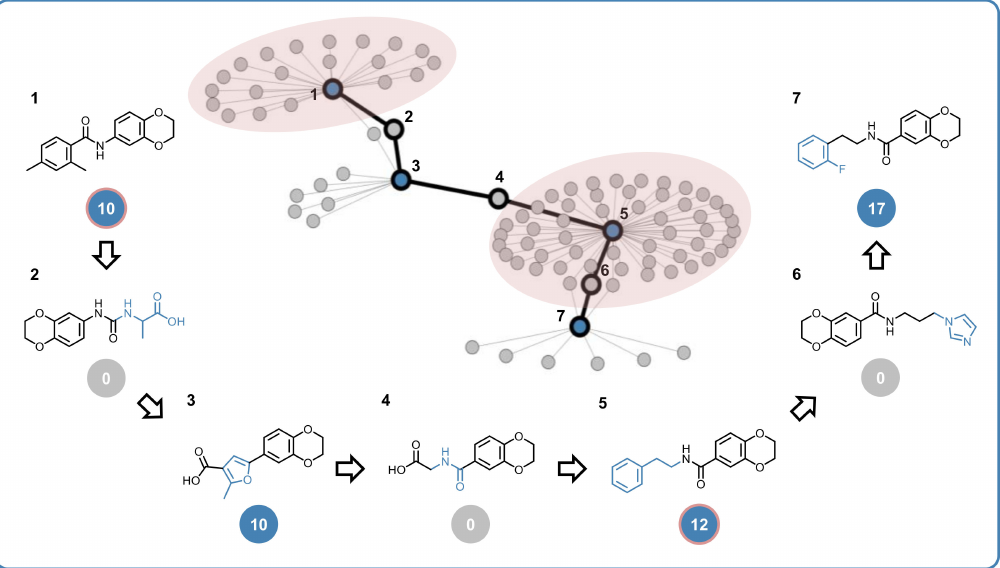
Figure 5. Shown is a section of the PC network formed by multiclass ligands and non-promiscuous or consistently inactive compounds. Nodes represent compounds and edges pairwise PC